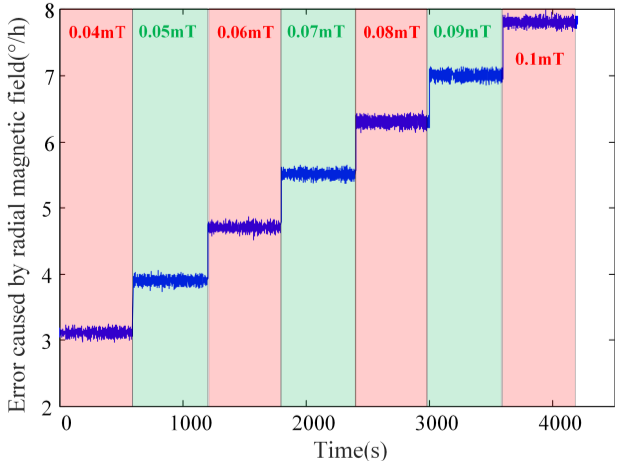
Figure 9. Experimental results of magnetic induction errors in radial magnetic field.